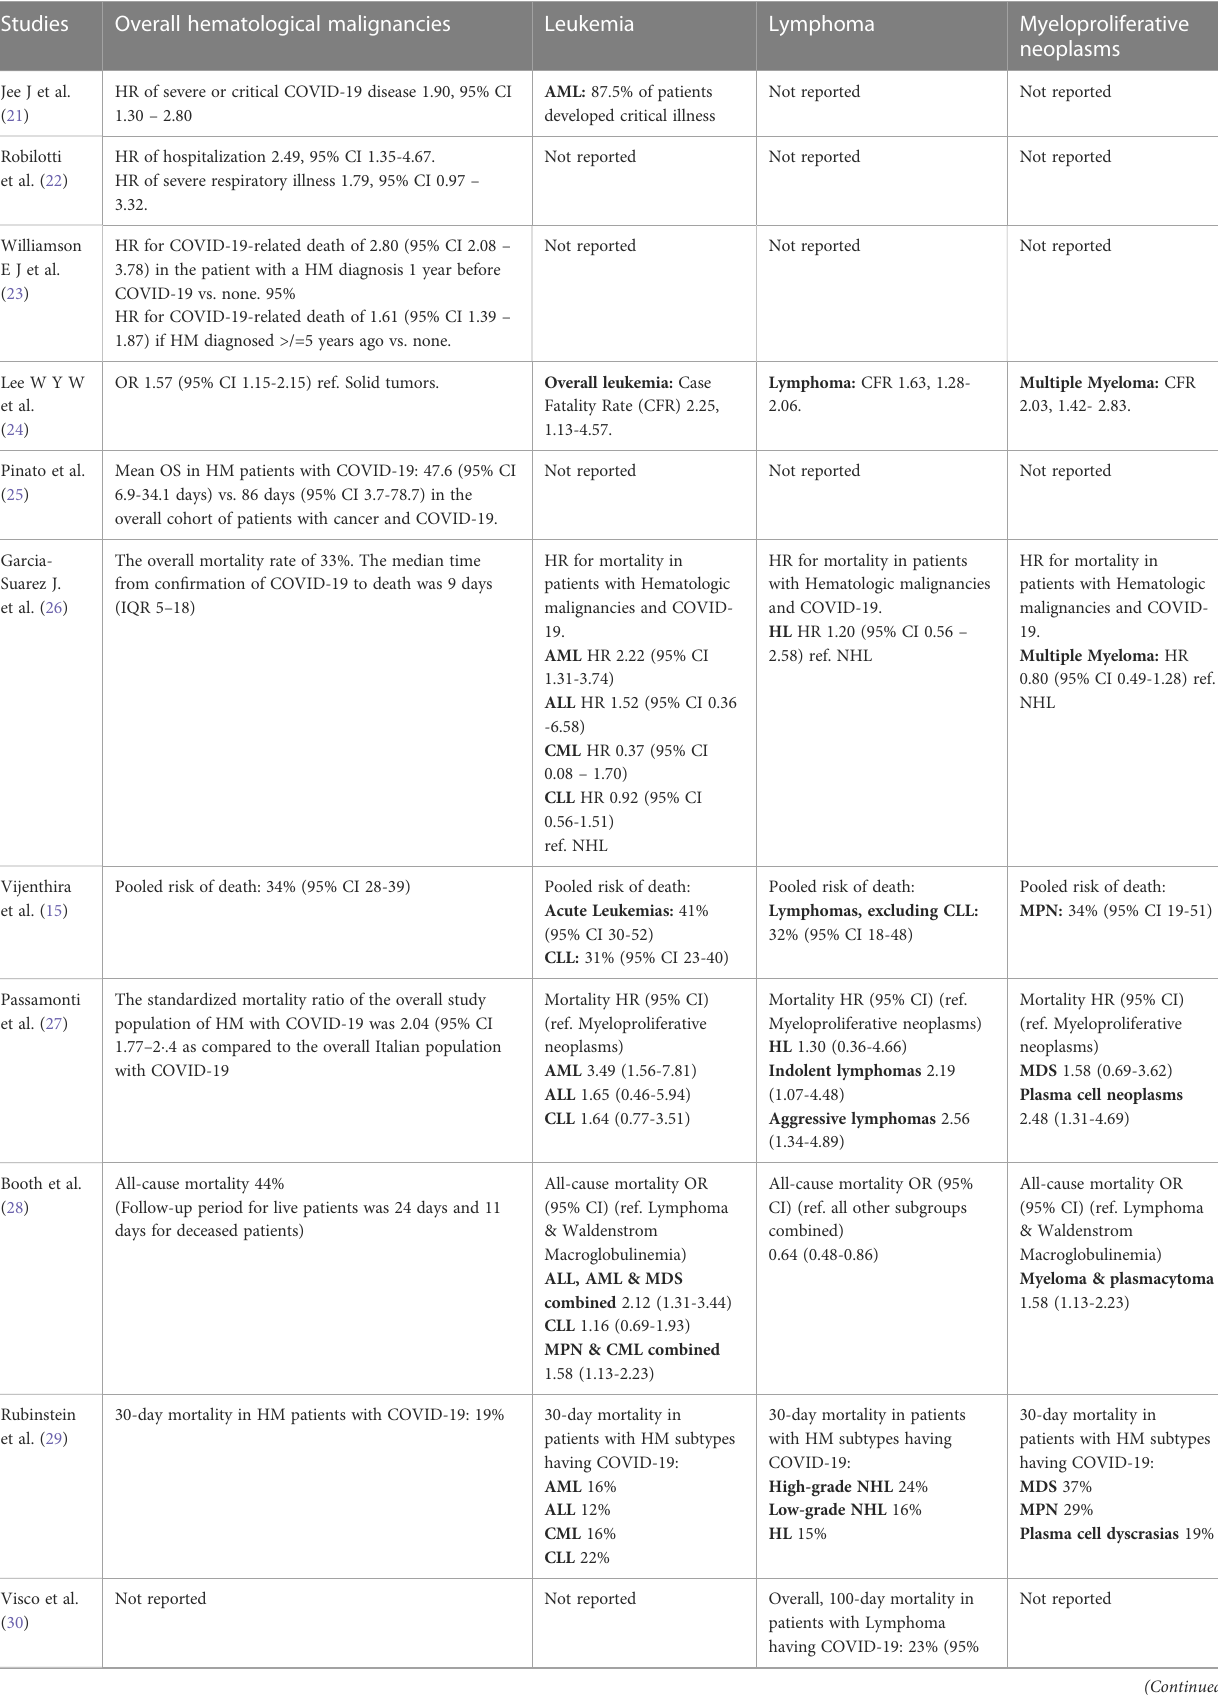
TABLE 2 Outcomes in hematological